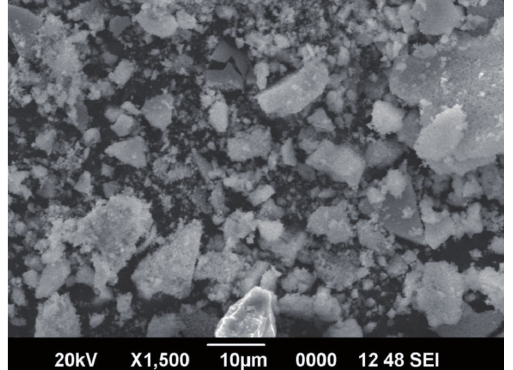
F 7: SEM image of Gd